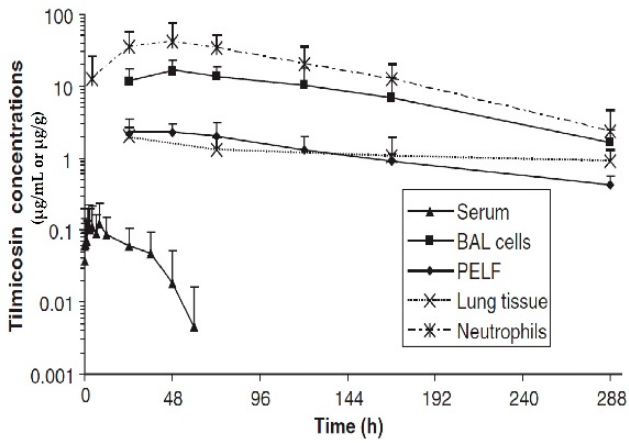
Figure 6. Tilmicosin concentrations in serum, bronchoalveolar lavage (BAL) cells, pulmonary epithelial lining fluid (PELF) ( µ g/mL), and lung tissue ( µ g/g) of 7 foals following a single IM dose of